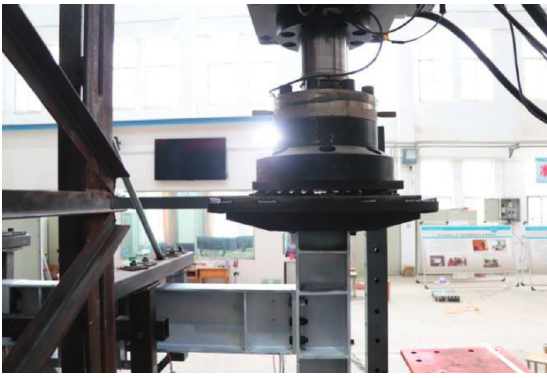
Figure 7: Column top actuator. Figure 8: Column foot